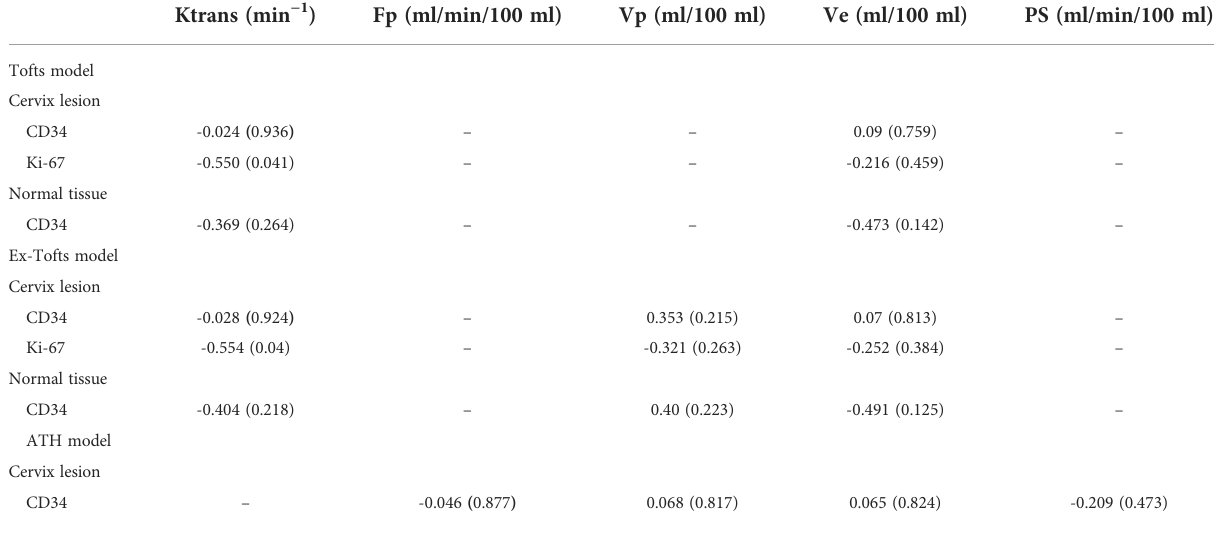
TABLE 3 Results of Pearson correlation immunohistochemical indicators (CD34 and Ki-67) and DCE kinetic parameters (Ktrans, Fp,Vp, Ve, PS) from Tofts, Ex-Tofts, ATH, SC, and DP models of cervix lesion and normal tissue in Center 1, withcorrelation coef fi cients and p-values in the